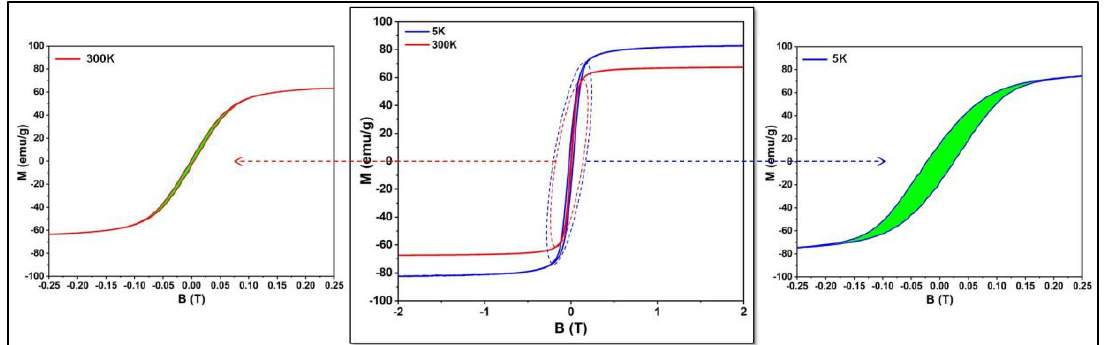
Figure 2. Hysteresis curves recorded at 5 and 300 K for the SPIONs samples.